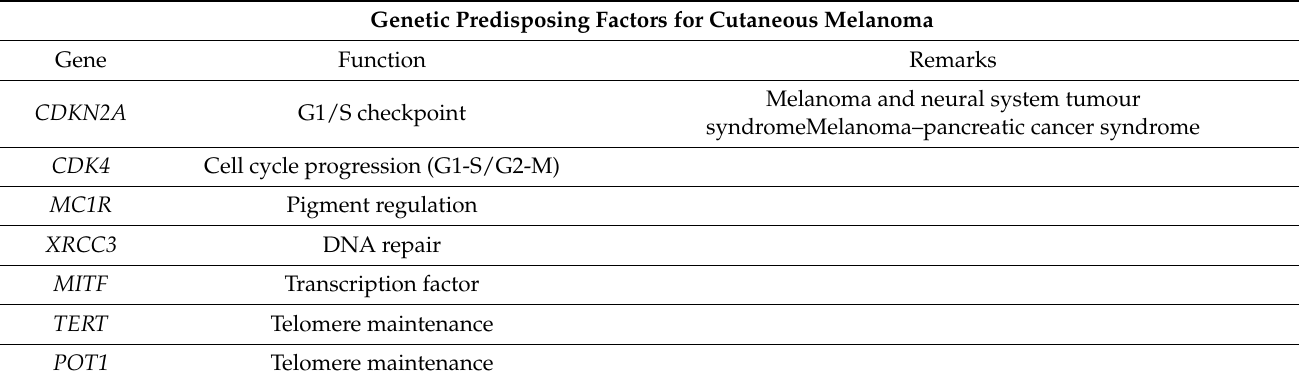
Table 4. Genetic predisposition factors for cutaneous melanoma. Genetically defined conditions are listed. Genetic Predisposing Factors for Cutaneous